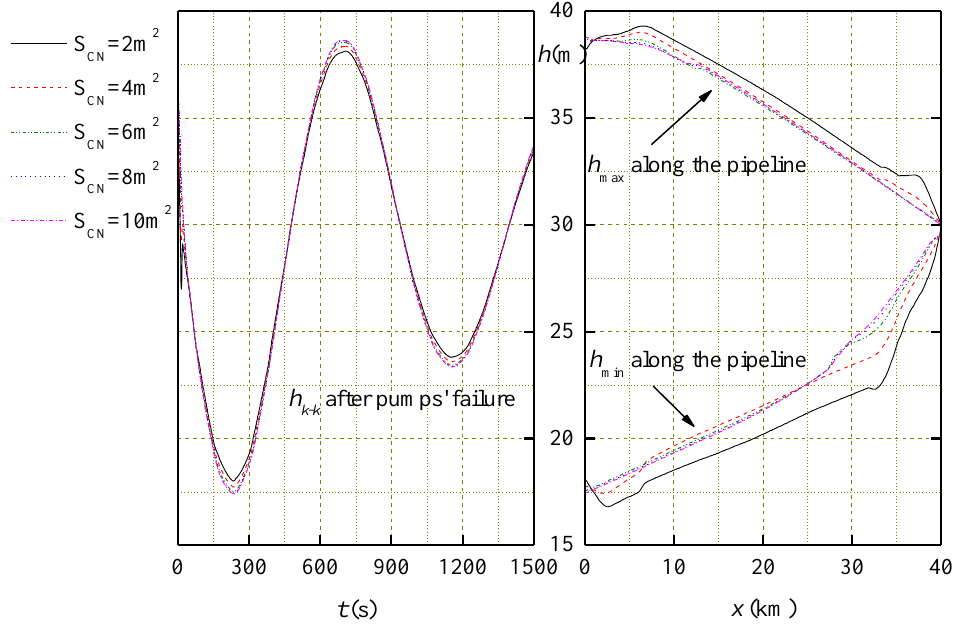
Figure 8. Key transient pressure and the extreme water head along the pipe.